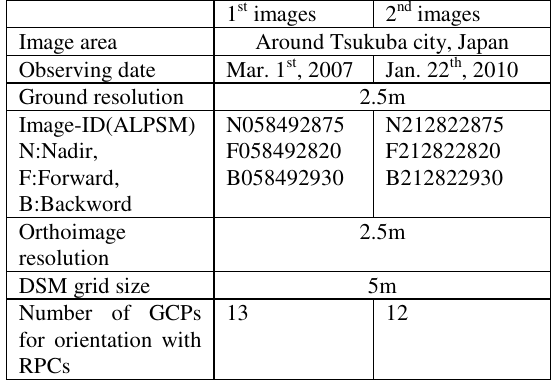
Table 1: Specification of used images and condition 1 st images 2 nd images Image area